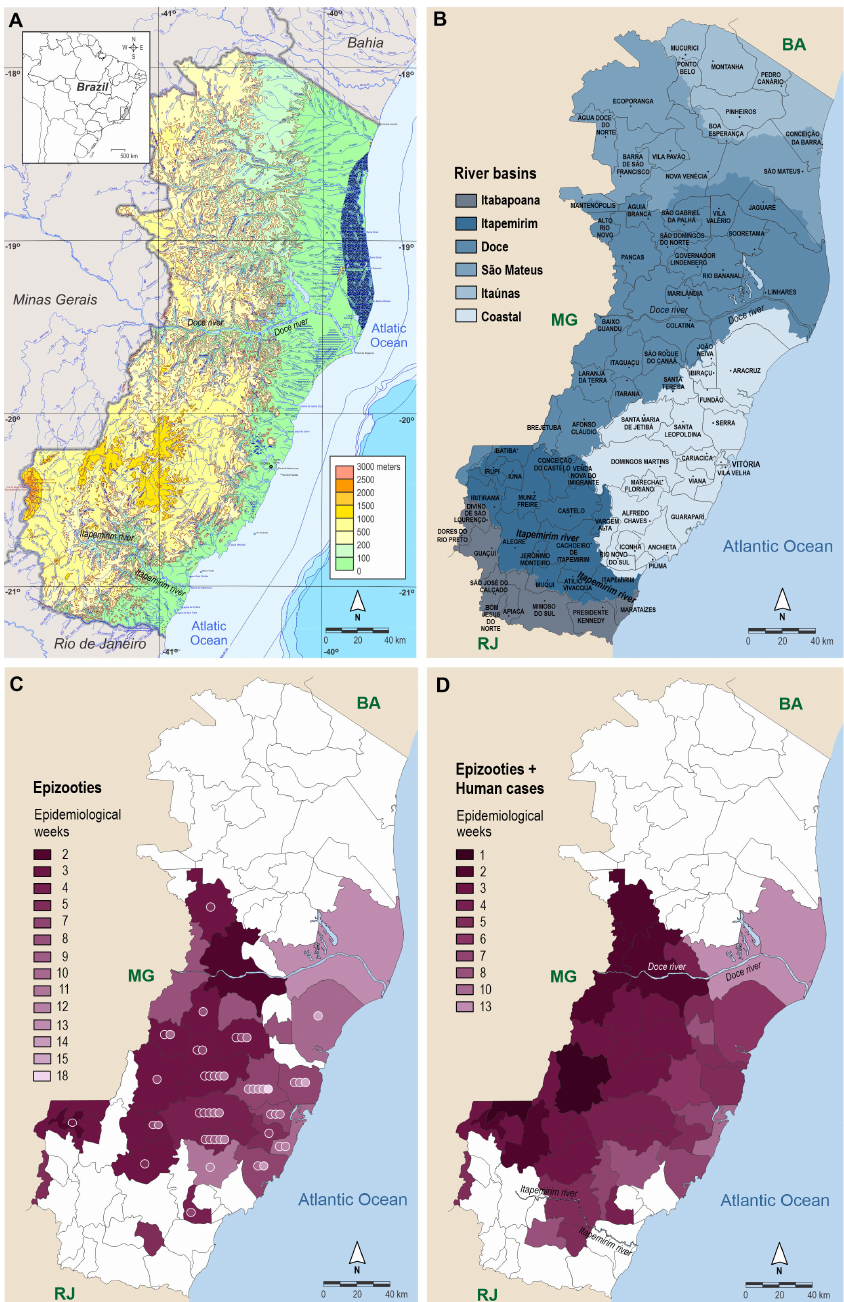
Figure 1. Spatiotemporal spread of YFV in the state of Espírito Santo (ES) during the 2017 outbreak. ( A ) Relief of ES. ( B ) Main river basins through which the virus entered the state in January 2017, including the Doce River Basin (to the North) and Itapemirim River Basin (to the South). ( C , D ) spatiotemporal spread of YFV by epidemiological week (EW). Each municipality is highlighted with the colour corre- sponding to the EW in which the YFV infection was first registered. The first recorded cases are in a darker tone, and the tones lighten over time. In C, the spatiotemporal evolution of epizootics registered in the Notifiable Diseases Information System (“Sistema de Informaç ã o de Agravos de Notificaç ã o: SINAN”). The circles within each municipality represent the number of EWs for which there were YFV epizootic records. In ( D ), the first records of YFV in each municipality for both epizootic (SINAN) and human cases (“Sistema de Gerenciador de Ambiente Laboratorial: GAL”). Neighboring states: Bahia (BA), Minas Gerais (MG), and Rio de Janeiro